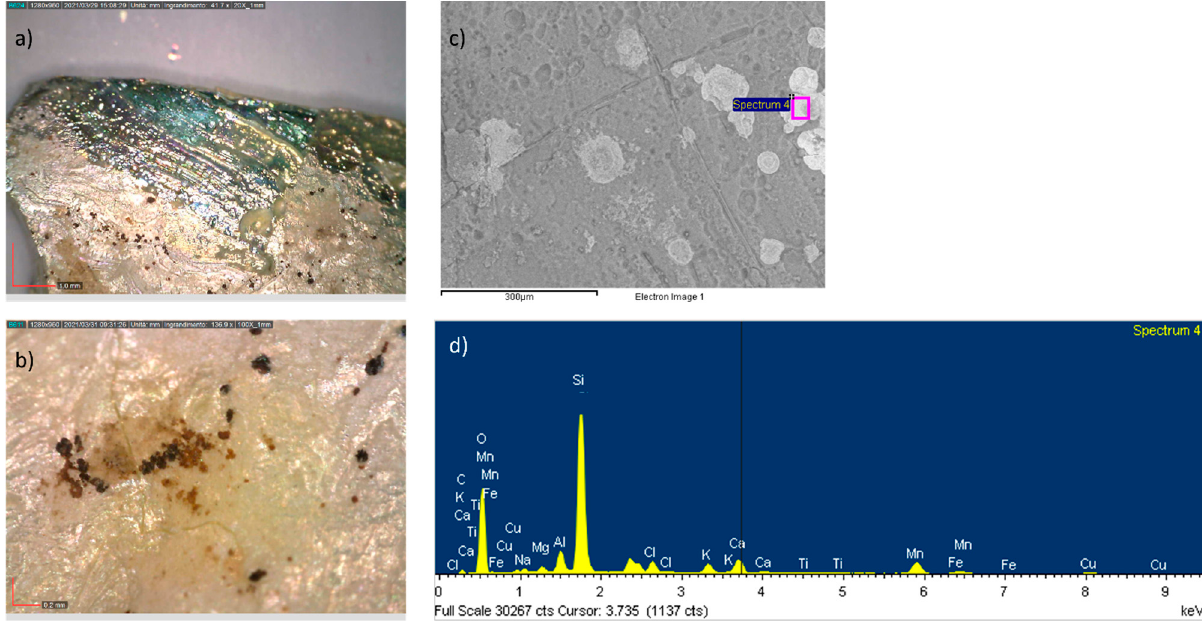
Figure 3. Iridescence on glass fragment KK_d3: ( a ) OM documentation; ( b ) magnified detail of the black stains (100×); ( c ) BSE image of the surface; ( d ) EDS spectrum acquired on the black stains.